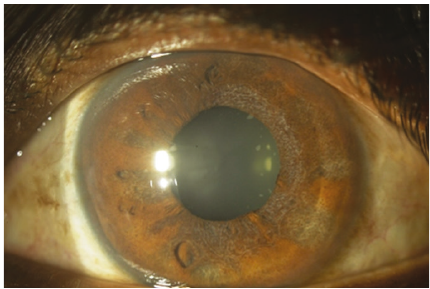
Figure 1: right eye showing iris atrophic patches.